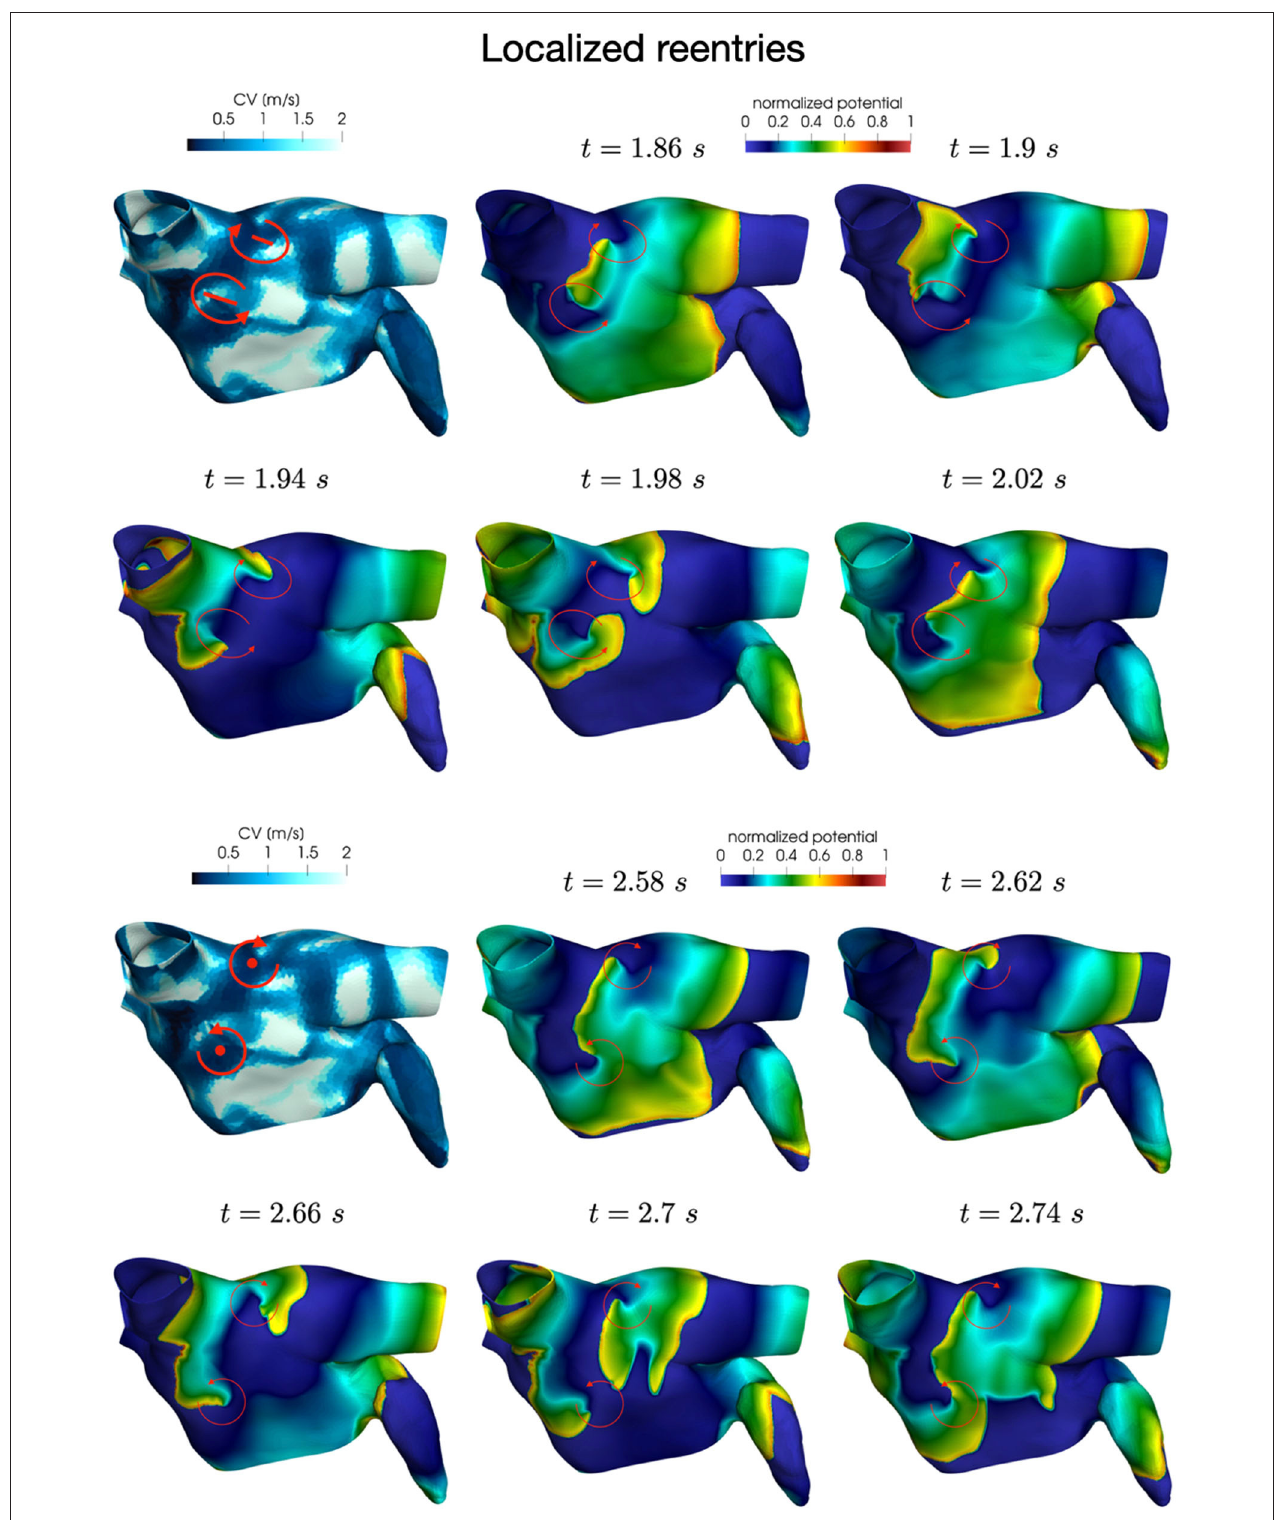
FIGURE 9 | Anchor points stabilization in area of severe slow conduction and enhanced electrical remodeling.